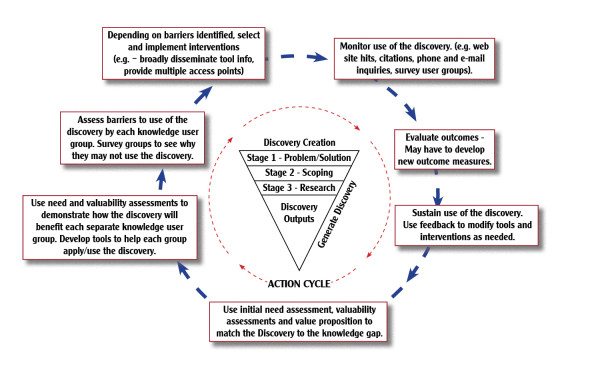
Discovery Outputs.